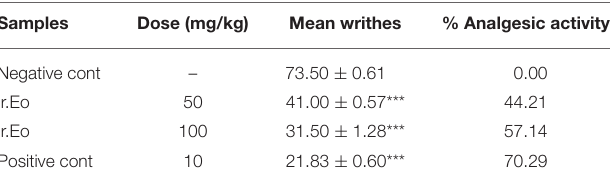
TABLE 3 | Effect of Essential oil of Isodon rugosus on formalin induced pain in mice. Samples